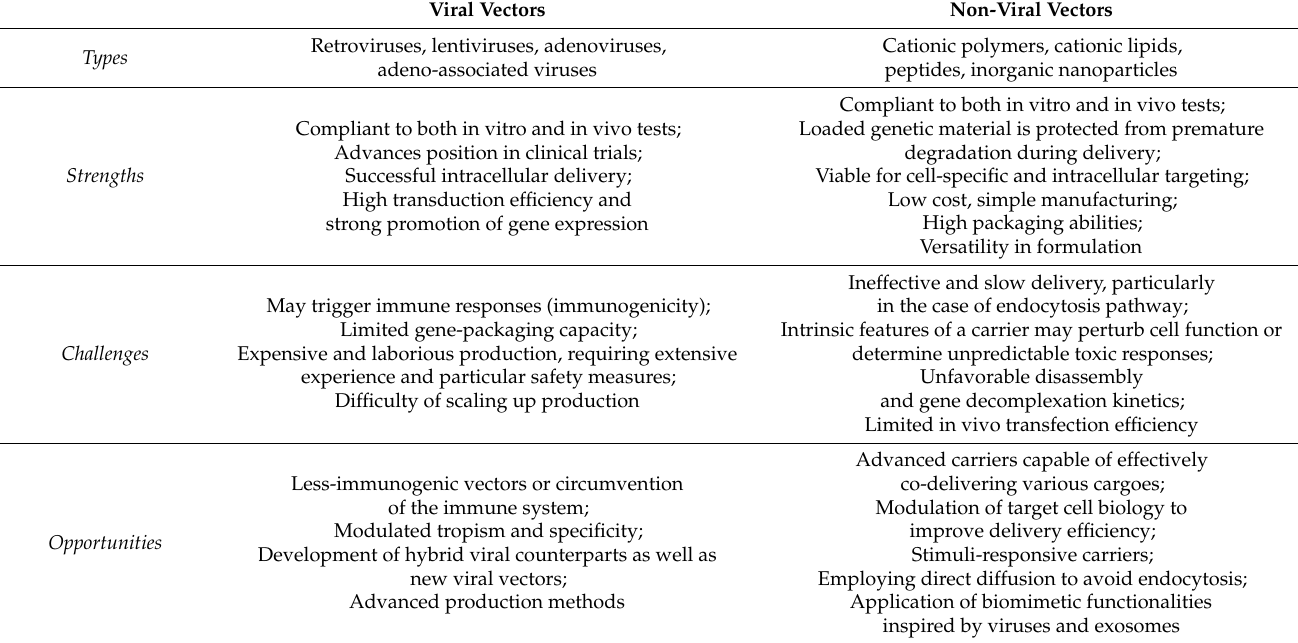
Table 1. Strengths, challenges and opportunities of viral and non-viral gene therapy drug delivery technologies